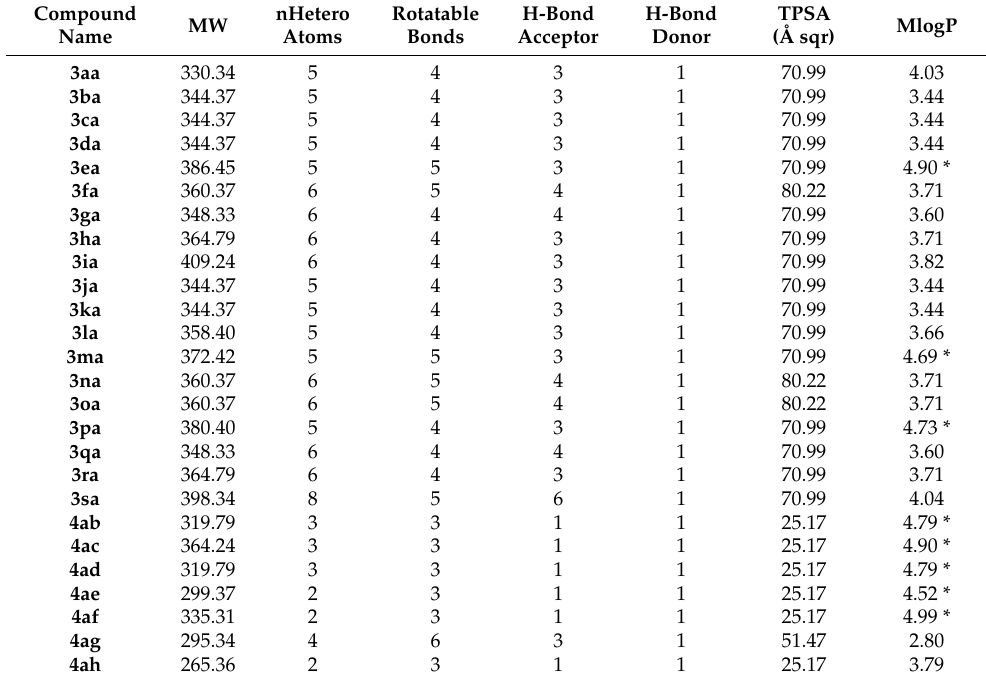
Table 2. Physiochemical properties of the compounds predicted using SwissADME.